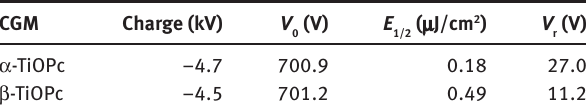
Table 1: The photosensitivity properties of the OPCs fabricated with the α - and β -TiOPc NPs.